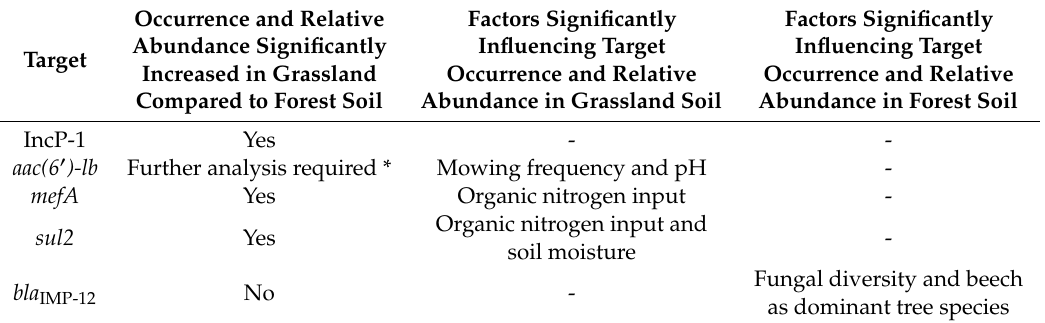
Table 2. Summary of factors significantly a ff ecting target antibiotic resistance genes and mobile genetic elements in soil ecosystems analyzed in this study. Targets showing increased occurrence as well as relative abundance in grassland compared to forest soil are depicted. Furthermore, factors significantly influencing the occurrence as well as relative abundance of targets in grassland (mowing frequency and organic nitrogen input) or forest soil (fungal diversity and beech as dominant tree species) are depicted.